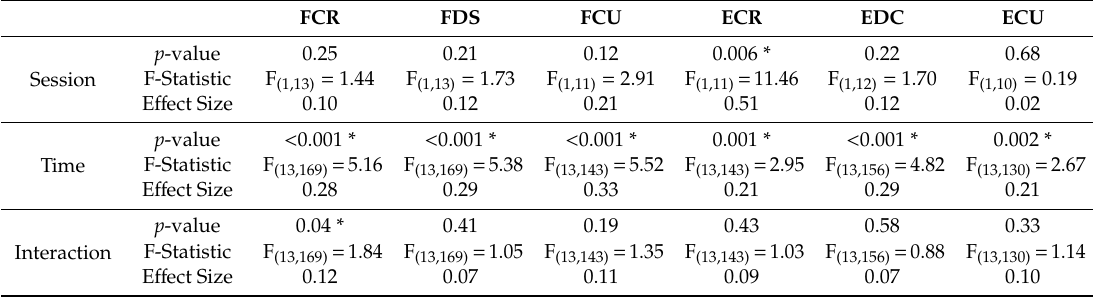
Table 4. Results from two-way repeated measures ANOVAs performed on MEP amplitudes normalized to